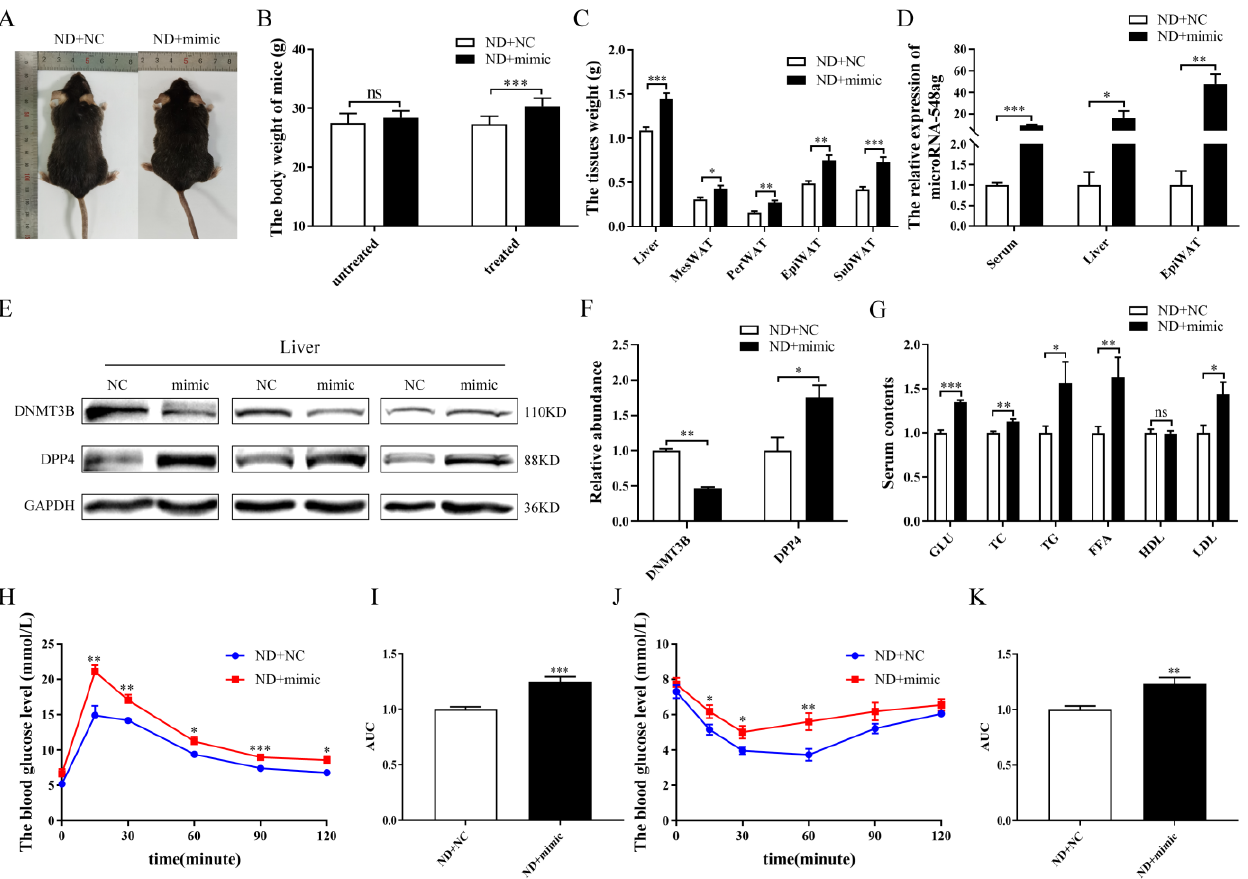
Figure 5. Effect of miR-548ag on the expression levels of DNMT3B and DPP4 in vivo. ( A ) The gross morphology of ND + NC and ND + mimic mice. ( B ) Comparison of body weights prior to and after the intraperitoneal injection of the mimic ( n = 8). ( C ) The weights of the liver and adipose tissues ( n = 8). ( D ) The levels of miR-548ag in the serum, liver tissue, and EpiWAT of the mice ( n = 6). ( E , F ) The protein expressions of DNMT3B and DPP4 in the liver. ( G ) The levels of blood glucose, TC, TG, FFA, HDL, and LDL ( n = 8). ( H ) IPGTT assay results ( n = 8). ( I ) The quantification of glucose tolerance. (J) ITT assay results ( n = 8). ( K ) The quantification of insulin sensitivity. (The p -values obtained in the t -test and non-parametric rank sum test are indicated. The data are presented as mean ± SEM. * p < 0.05, ** p < 0.01, and *** p < 0.001 indicate a significant difference).